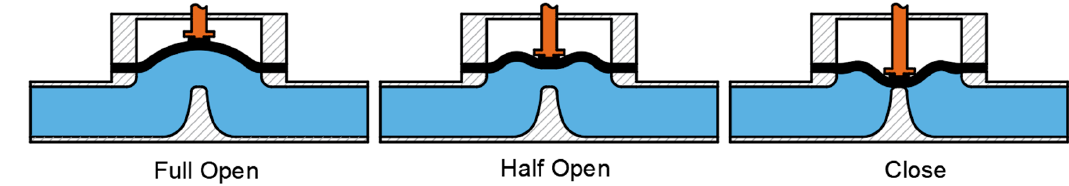
Figure 5. Working Principle of Weir Diaphragm Valve.